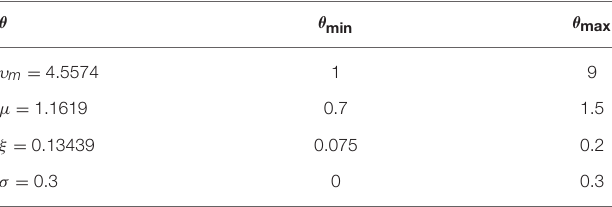
TABLE 2 | Bounds and estimations of the best set of parameters of the modified Fokker-Planck equation to reproduce the experimental volume stationary distribution of P. acidilactici